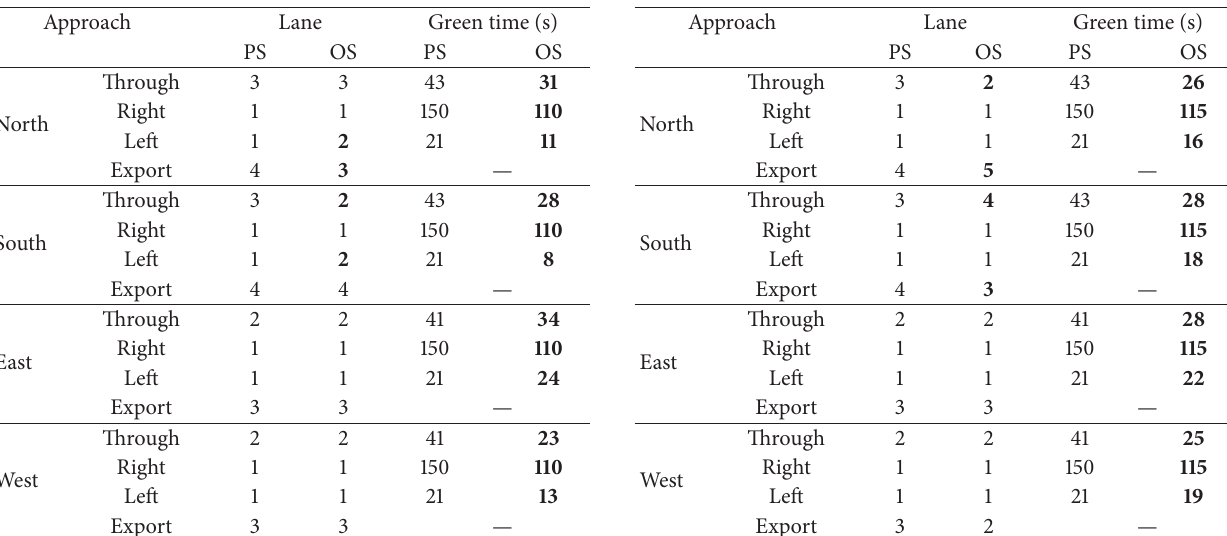
Table 5: Optimization for evening